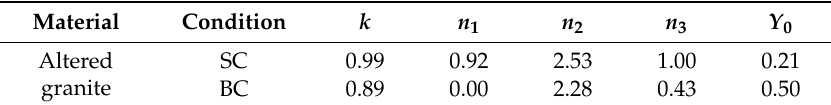
Table 6. Back-calculated parameters of the model, in order to fit with the experimental values. The values of k , n 1 , n 2 and n 3 are dimensionless, and Y 0 is in m. SC is the abbreviation for single particle compression, and BC is the abbreviation for bed particle compression.